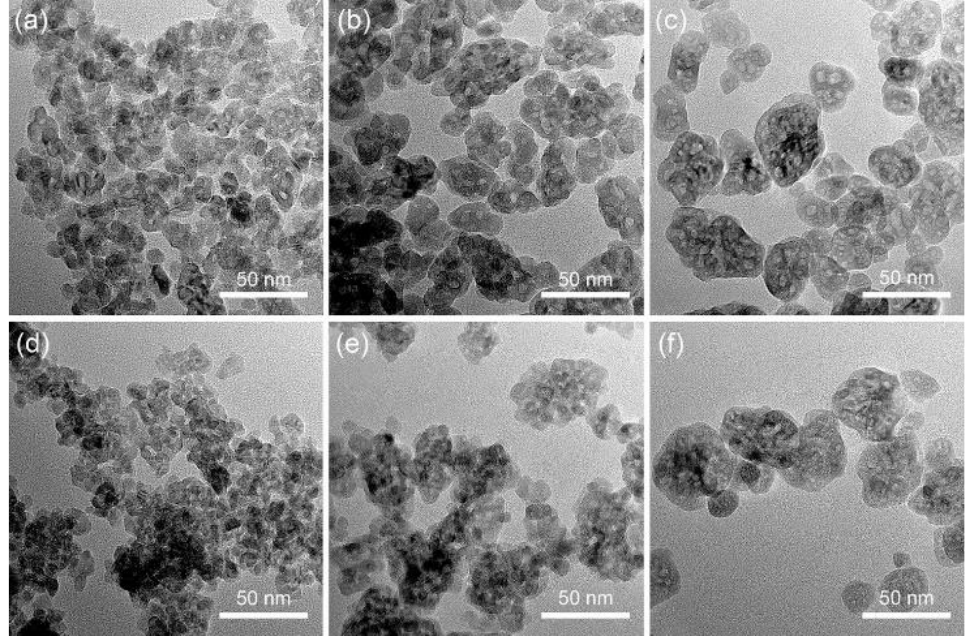
Figure 3. The TEM image of ( a ) M-ZrO 2 -1, ( b ) M-ZrO 2 -2, ( c ) M-ZrO 2 -3, ( d ) M-SZ-1, ( e ) M-SZ-2, and ( f ) M-SZ-3.